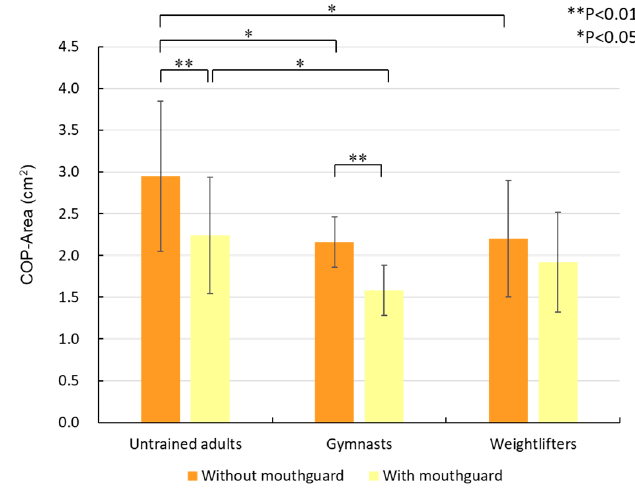
Figure 6. Comparison of the area enclosed by the trajectory of the center of pressure fluctuation (COP-Area) among participants by mouthguard condition. Measurements are expressed as means ± SD. The error bar indicates the standard error of the mean. ** p < 0.01, * p < 0.05: denotes statistically significant difference.